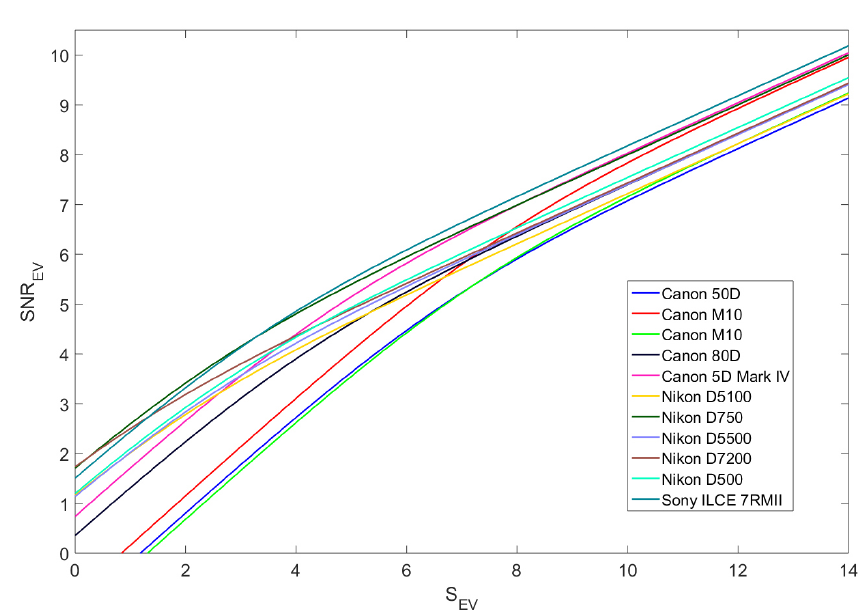
Figure 15. Photographic SNR curves for ISO 100.